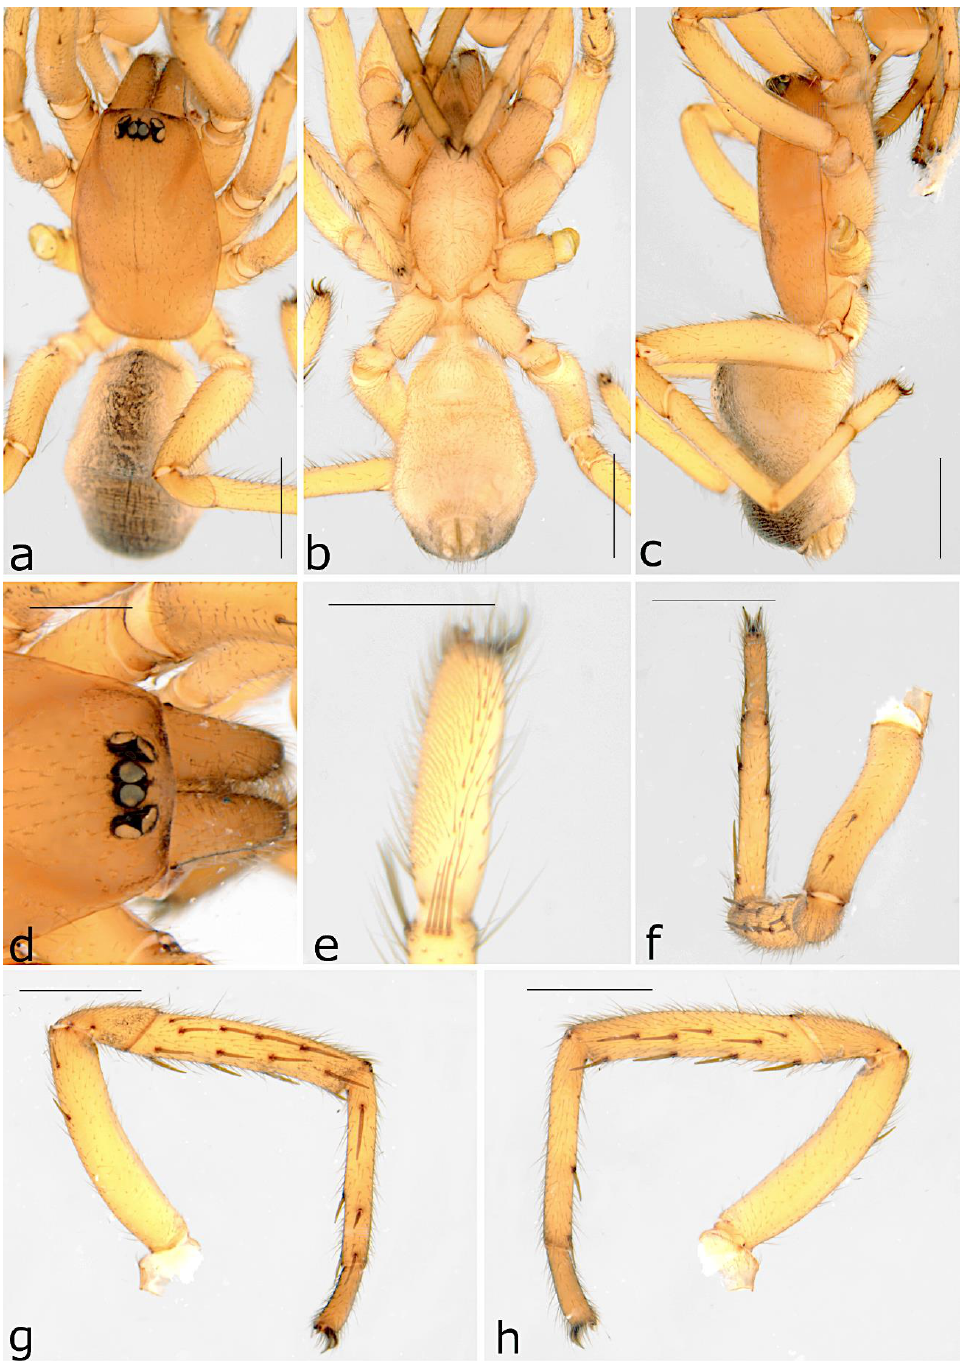
Figure 53. Ariadna simplex sp. nov. ♂ holotype (SAMA NN30482) from the Gammon Ranges (SA): ( a ) habitus, dorsal view; ( b ) same, ventral view; ( c ) same, lateral view; ( d ) eyes, dorsal view; ( e ) left metatarsus IV, preening comb, retrolateral view; ( f ) left leg I, ventral view; ( g ) same, prolateral view; ( h ) same, retrolateral view. Scale bars ( a – c ) = 1 mm, d, ( e ) = 0.5 mm and ( f – h ) = 1 mm.